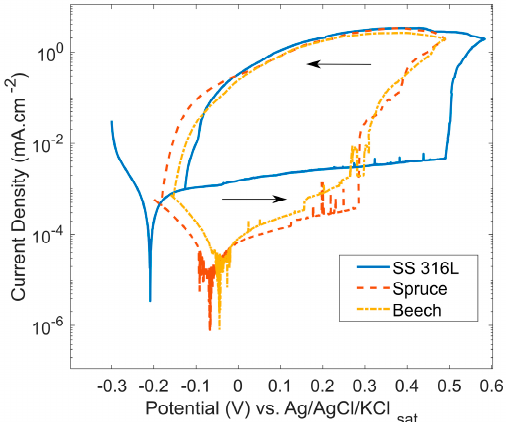
Figure 7. Cyclic potentiodynamic polarization curves of samples in phosphate buffered solution (PBS).